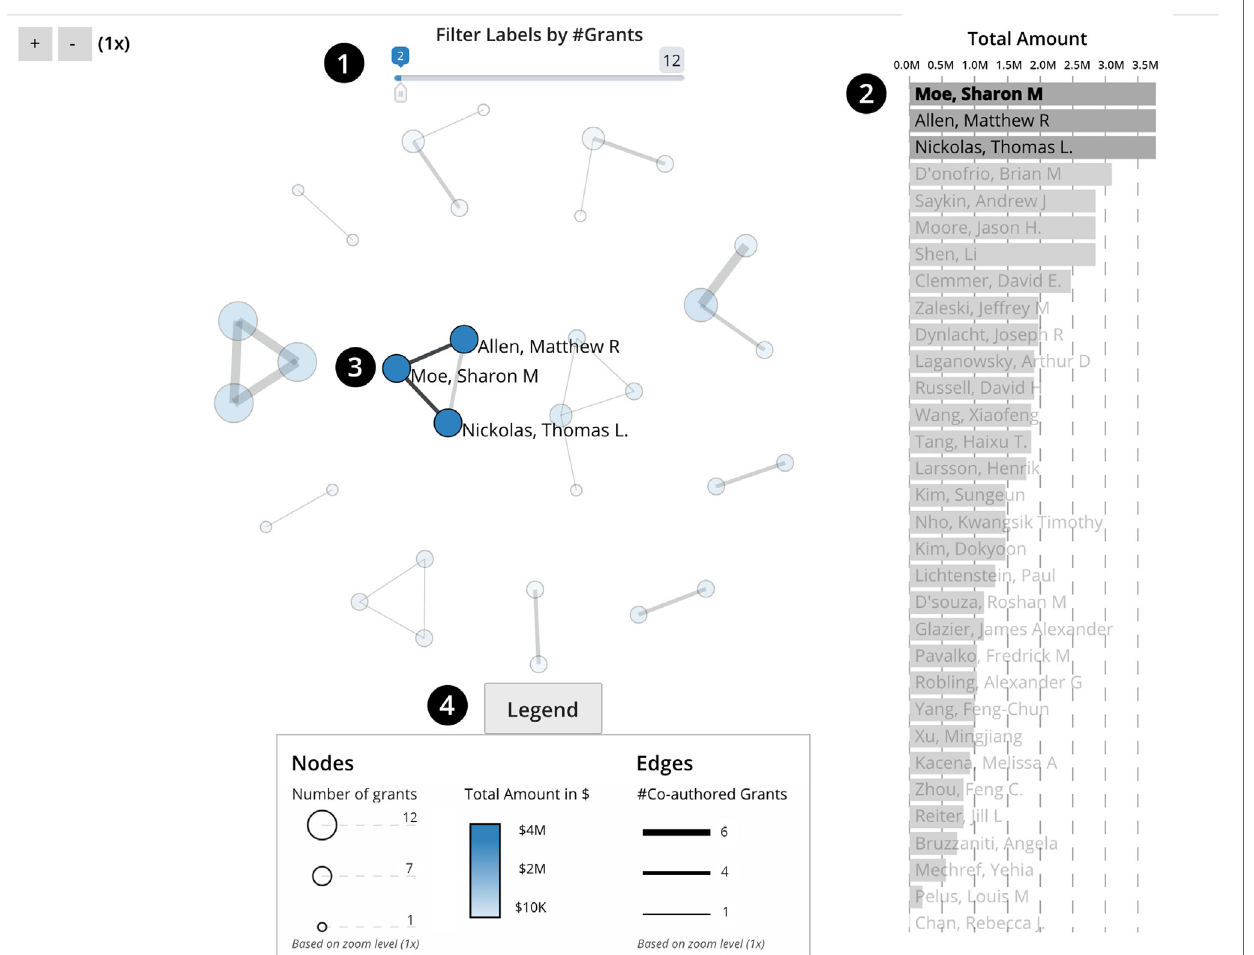
FigUre 7 | XD metrics on demand value analytics Co-PI Network Visualization , see interactive version at